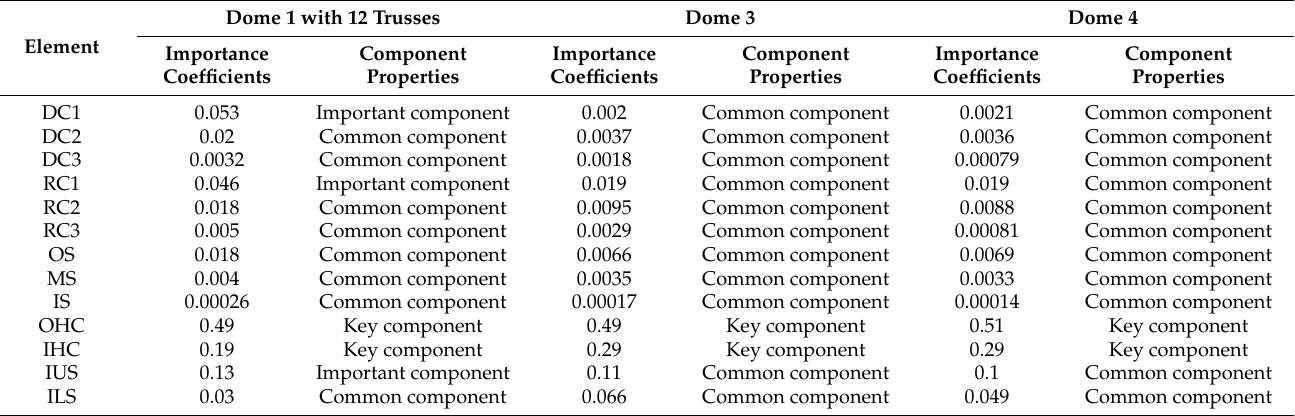
Table 4. Importance coefficients and importance categories of the structural elements for Dome 1 with 12 trusses, Dome 3 and Dome